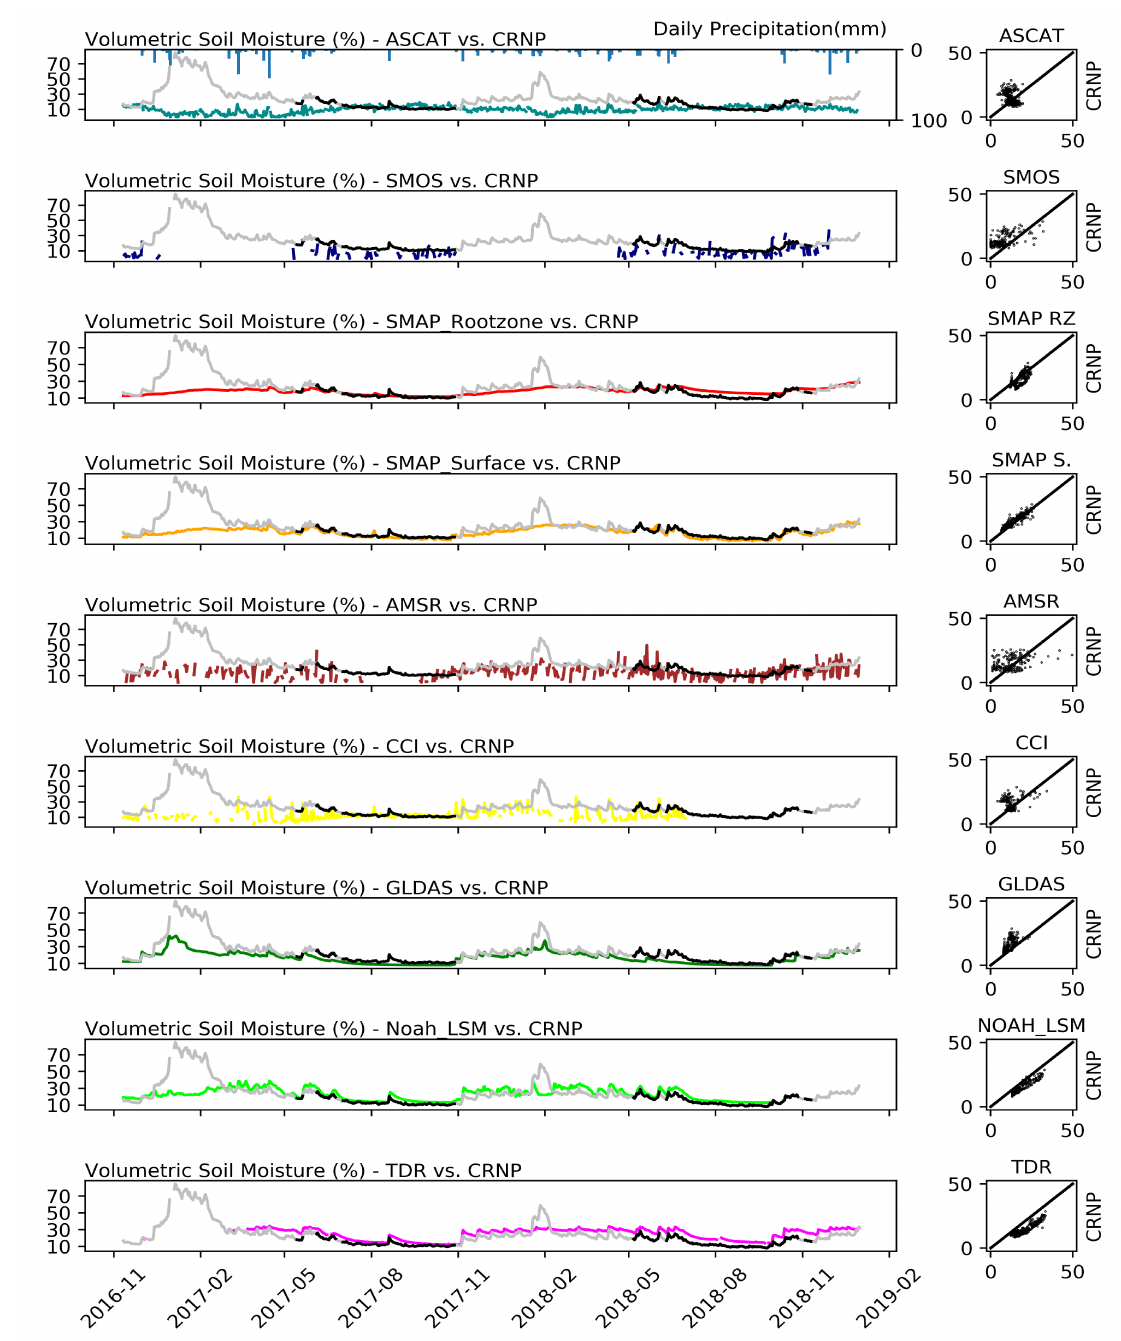
Figure 9. Time series of satellite soil moisture products. Filtered days due to snow are shown in grey, CRNP soil moisture values are shown in black, other soil moisture products are shown in different